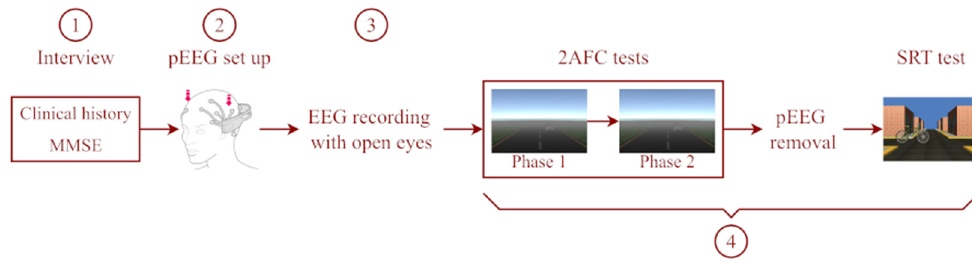
Figure 3. Steps of evaluation.